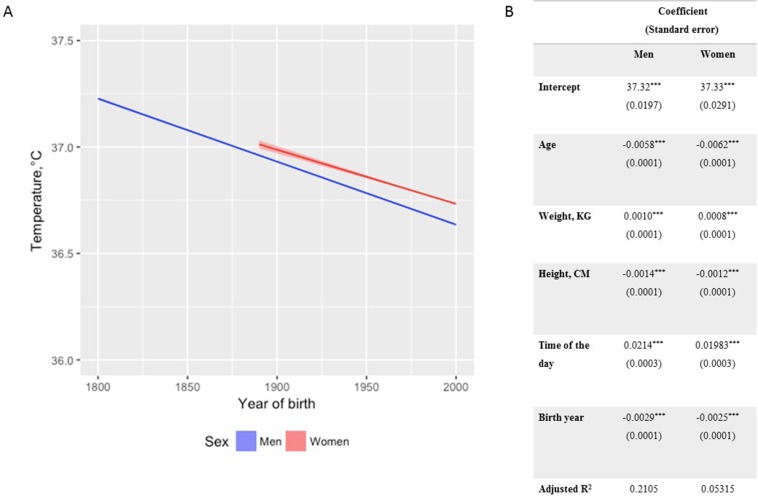
Model of mean body temperature over time in three cohorts by birth year controlling for the time of the day of the temperature measurement (white men and women).(A) Graph shows a decrease of predicted body temperature by birth year for both white men (blue line) and white women (red line) based on the linear regression coefficients displayed in B. No data for women were available for the period 1800–1890. For all measurements from UACWV, where time of the day was not available, the values of 12:00 PM (noon) were imputed. (B) Coefficients (and standard errors) from linear regression model including age, weight in kg, height in cm and birth year.Figure 1—figure supplement 4—source code 1.R code for Figure 1—figure supplement 4.